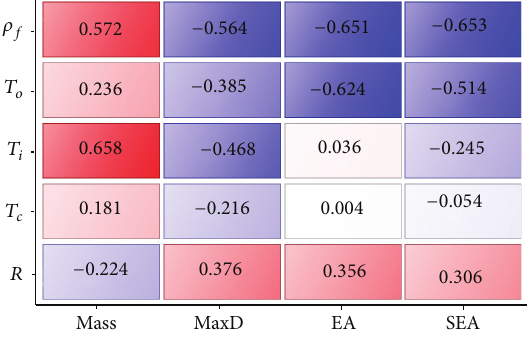
Figure 12: Correlation matrix between objective functions and design variables.